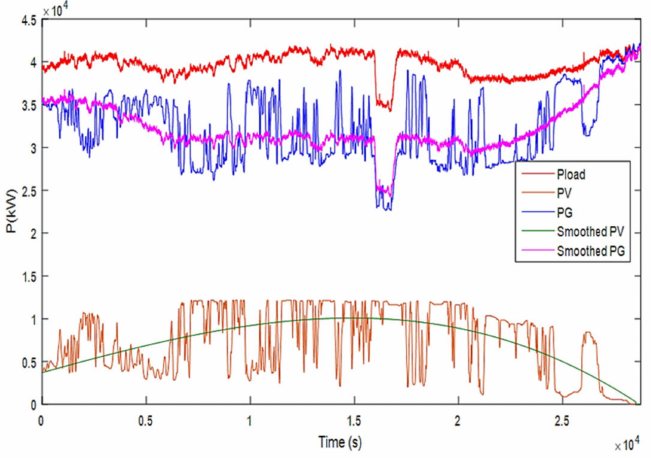
Figure 20. Illustration of the overall effect of